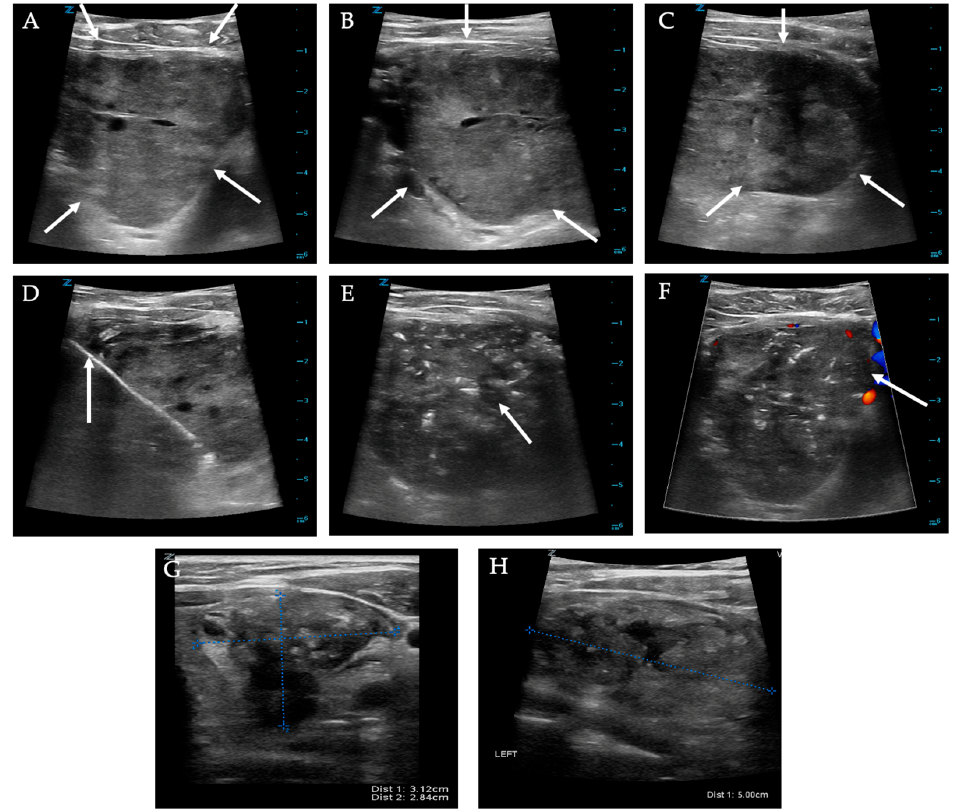
Figure 13. Thyroid nodule radiofrequency ablation . ( A – C ) Pre-ablation ultrasound images of solid nodule measuring 6.9 × 4.5 × 5.1 cm (white arrows). ( D ) Intraprocedure imaging shows trans-isthmic approach. ( E , F ) Post-ablation images show heterogeneous ablation changes throughout the nodule, and no internal vascularity. ( G , H ) One-month follow-up images show the nodule involuting and now measuring 5 × 3.1 × 2.8 cm.